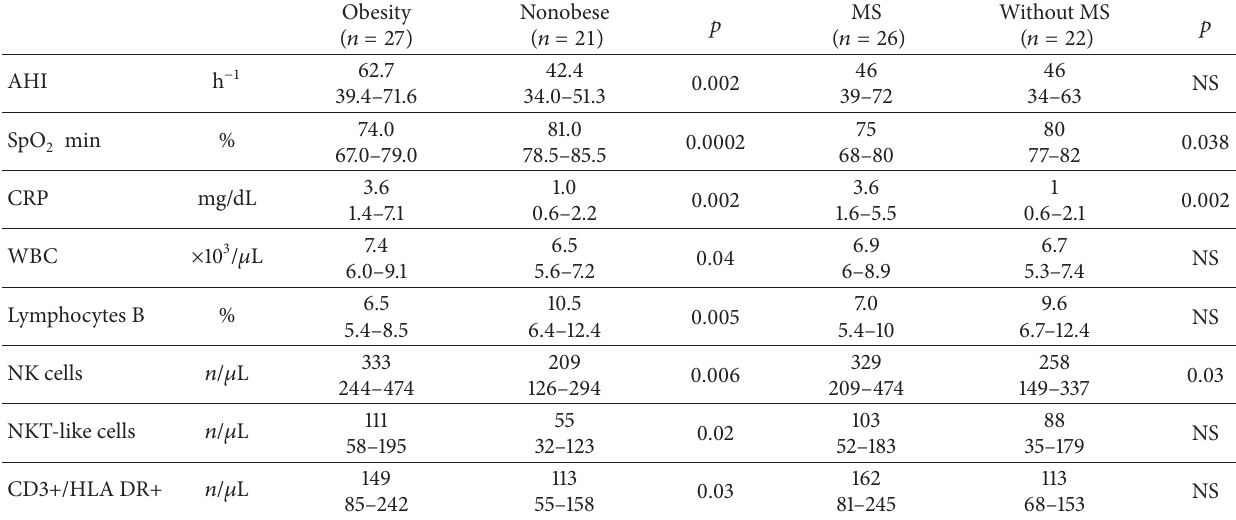
Table 3: Presentation of significant differences of OSAS indices, inflammatory mediators, and selected lymphocyte subpopulations between patients in relation to obesity and metabolic syndrome.